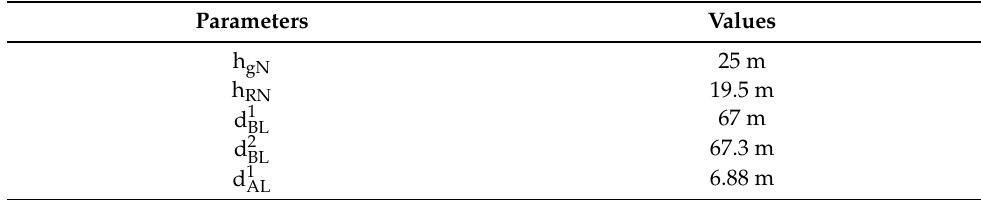
Table 1. Distance of the simulation